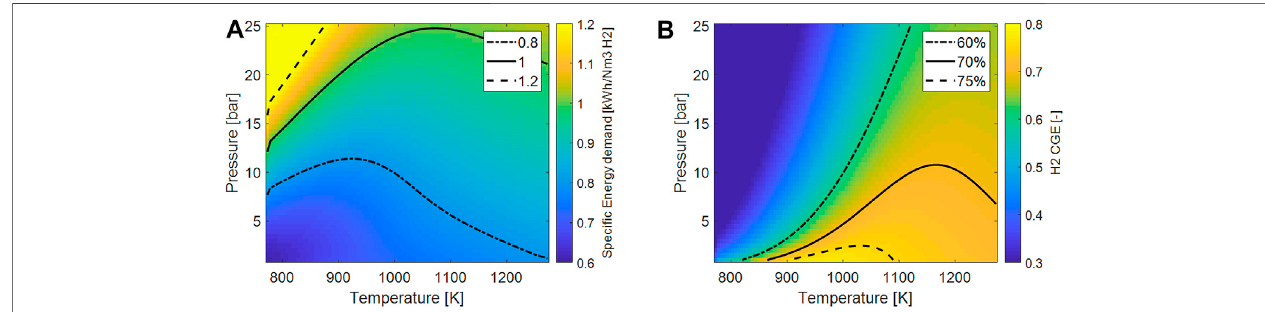
FIGURE 3 | (A) Plot of the ideal speci fi c energy consumptions per Nm 3 of H 2 as a function of process temperature and pressure; (B) plot of the H 2 cold-gas ef fi ciency (H 2 -CGE) as function of process temperature and